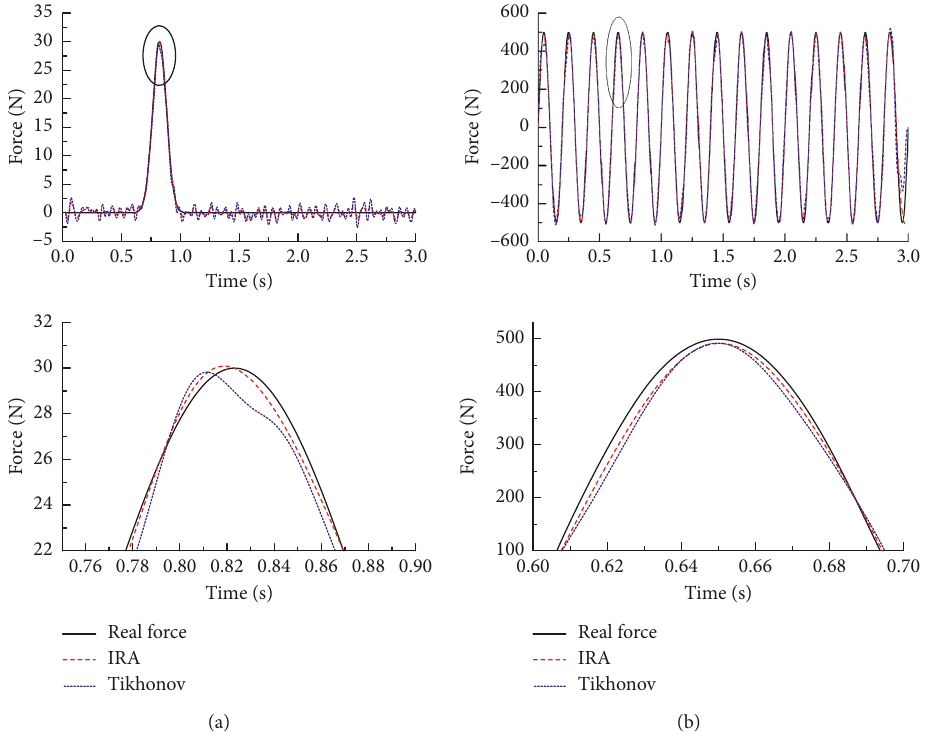
Figure 5: Loads identified by the responses with noise level of 20%: (a) impact load and (b) harmonic load.